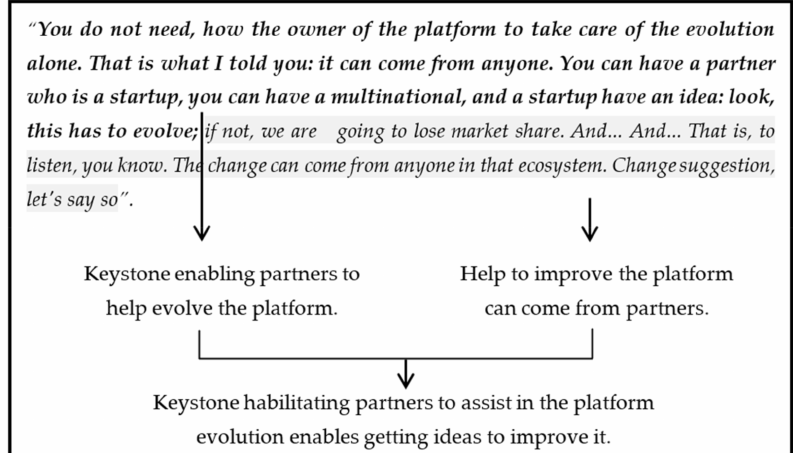
Figure 5. Open coding: creating relations.